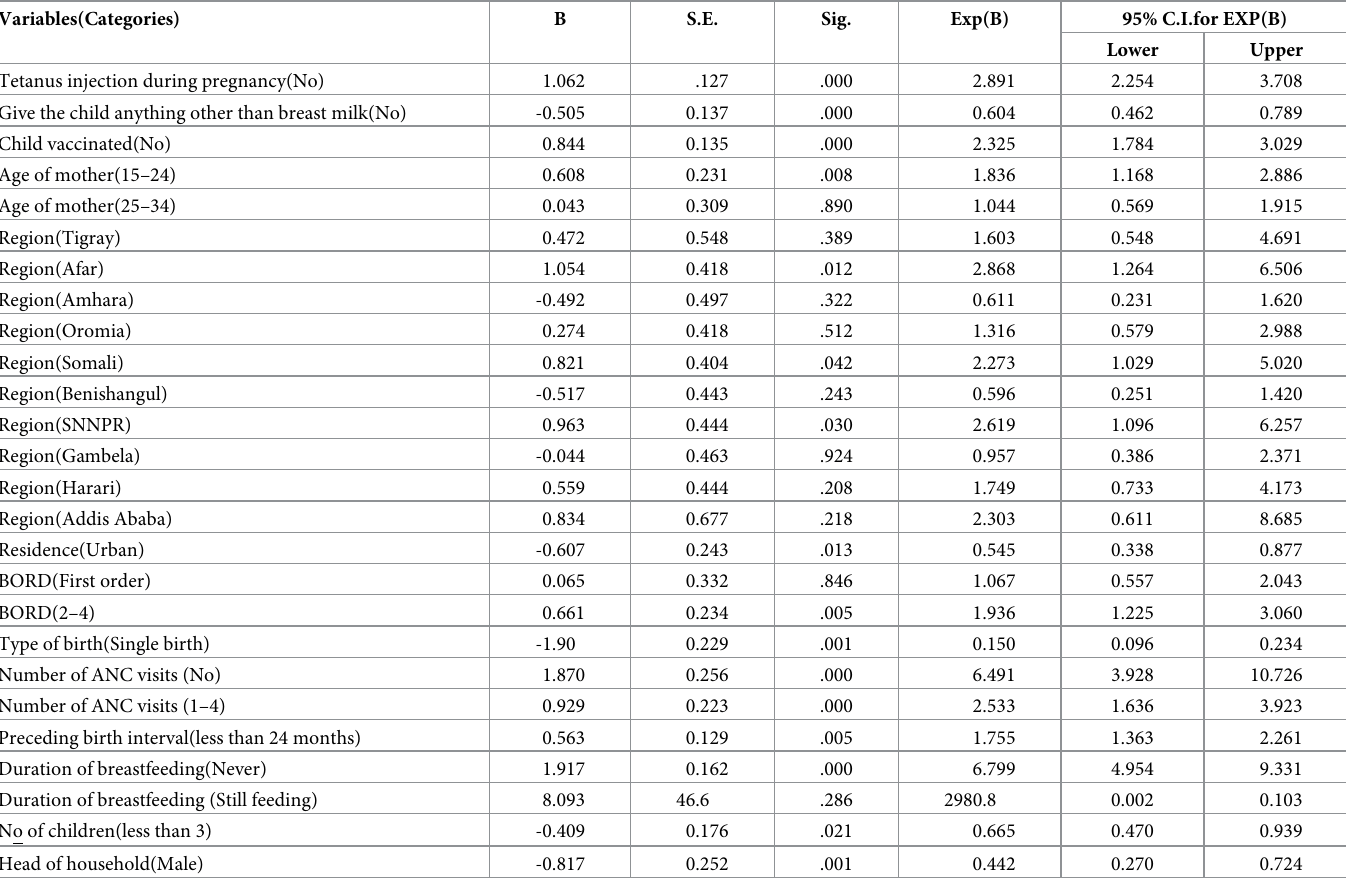
Table 4. Logistic regression model for post neonatal death in Ethiopia